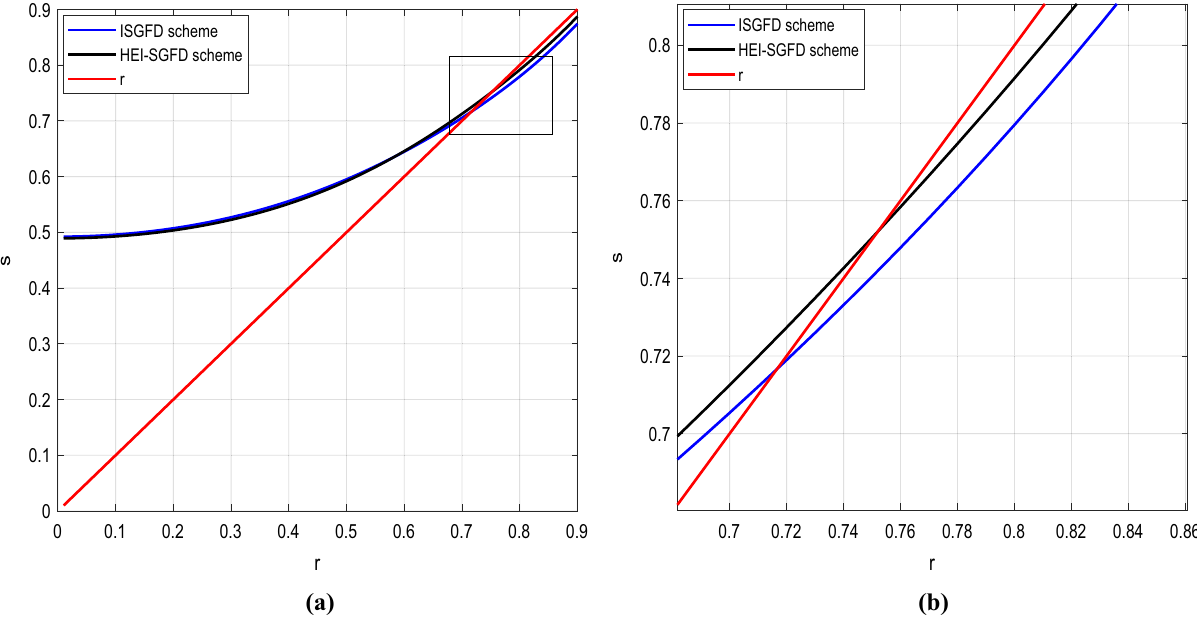
Figure 2. Comparison of the stability condition. ( a ) Stability condition of different implicit SGFD schemes; ( b ) local enlargement of ( a ) in the